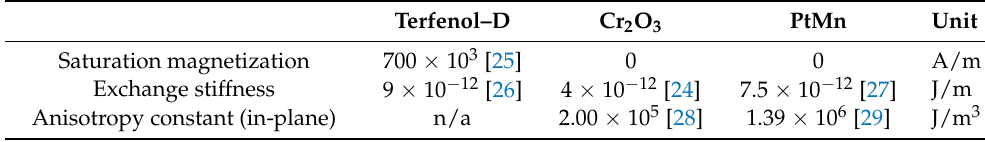
Table 2. Terfenol–D, Cr 2 O 3 , and PtMn properties.